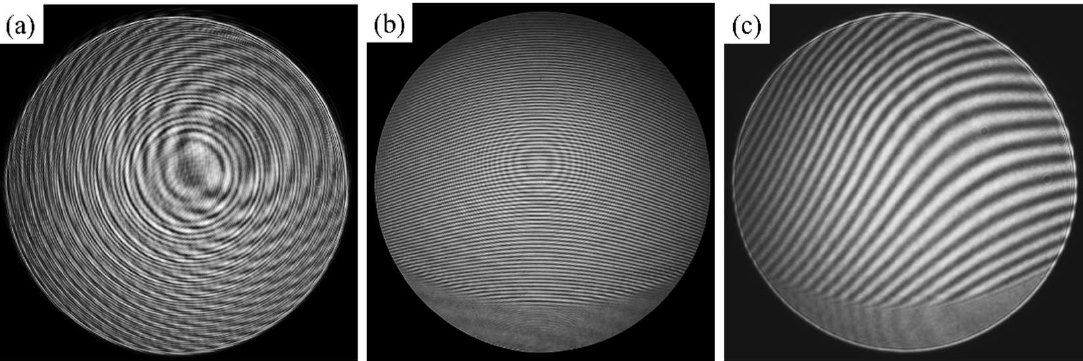
Figure 12. Interferograms captured during the process of system adjustment. The interferograms have been enhanced for better visual effects. ( a ) Stray fringes caused by scanning structure. ( b ) Dense interferogram with aliasing artifacts captured by the detector when the scanning structure was not perpendicular to the optical axis. ( c ) Sparse interferogram after adjusting the SUT.